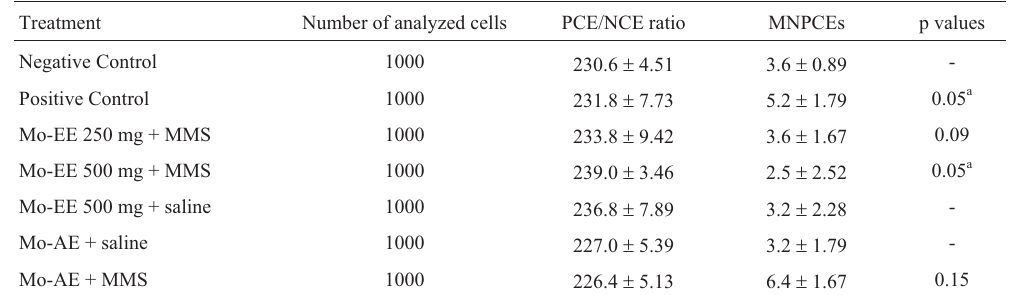
Table 3 - Effects of Melissa officinalis pre-treatments (gavage) on MNPCE frequencies (mean (cid:2) SD) in the bone marrow of mice, following intra- peritoneal injection with saline or methyl methanesulfonate (MMS) 40 mg/kg.